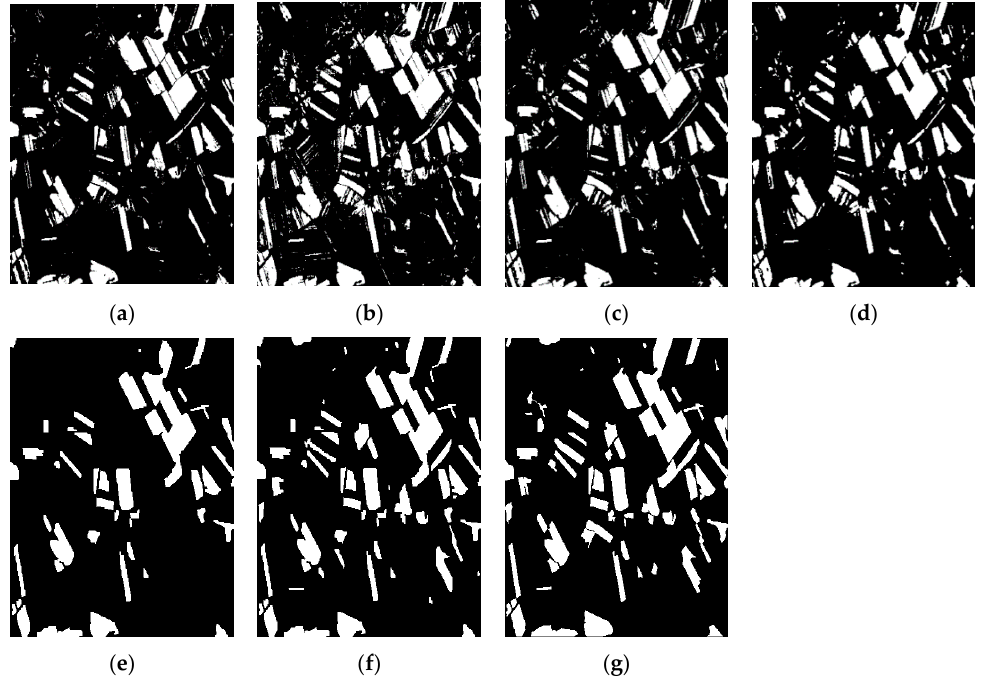
Figure 7. CD maps generated by different CD methods: ( a ) DRLSE; ( b ) CV; ( c ) MLSK; ( d ) EMAC; ( e ) OBCD; ( f ) SDCDUA and ( g ) reference map.